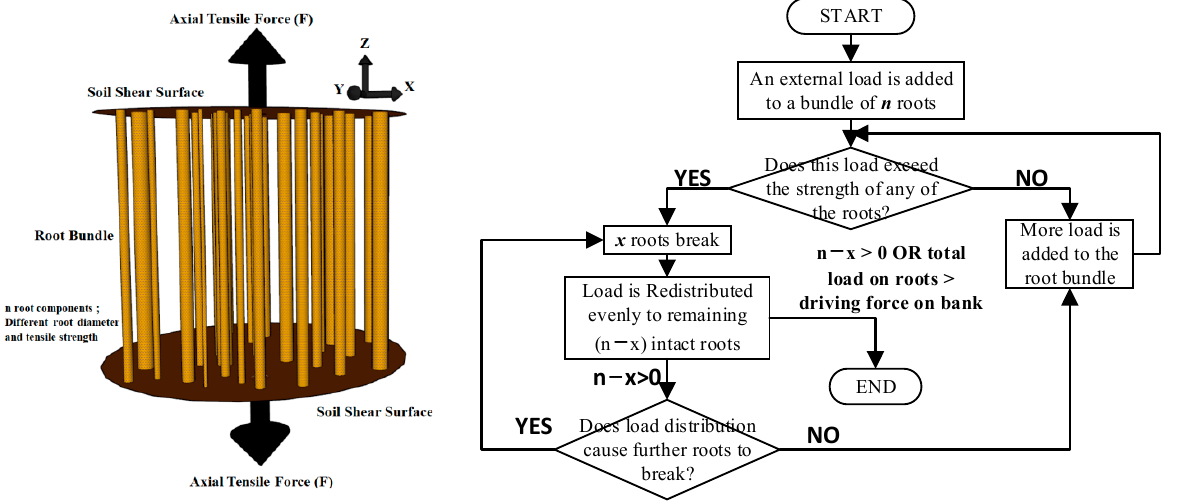
Figure 2. Schematic diagram of fiber bundle model and stress redistribution process (Modified from Pollen and Simon [34]).